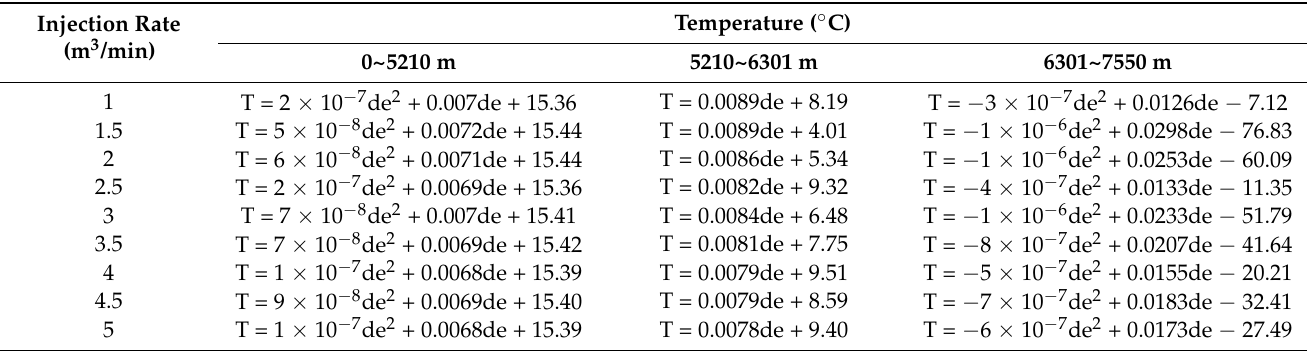
Table 2. The fitting formulas of temperature distribution in the tubing string under different injection rates (temperature is defined as T, de is depth).